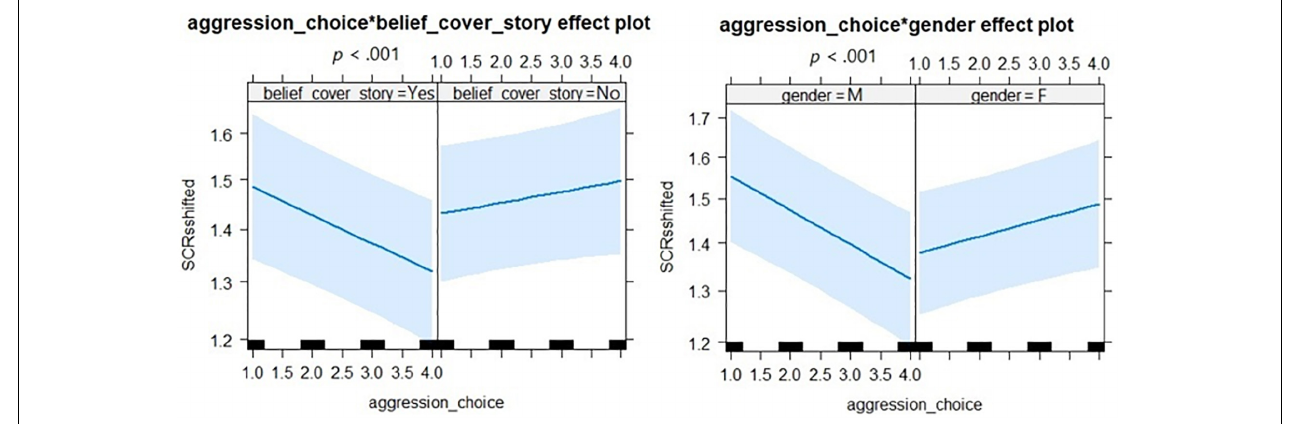
FIGURE 4 | Results of the generalized linear mixed-effects model analyses for SCRs in the pTAP. On the left side: interaction effect between aggression choice and belief in cover story (Yes: believed the cover story, No: did not believe the cover story). On the right: interaction effect between aggression choice and gender (M, males; F, females). SCRsshifted: skin conductance responses values shifted by adding 1. The thick black lines in the x -axis represent the aggression choices of the participants (blurriness levels selected). The error bars depict confidence intervals (95%). * p <